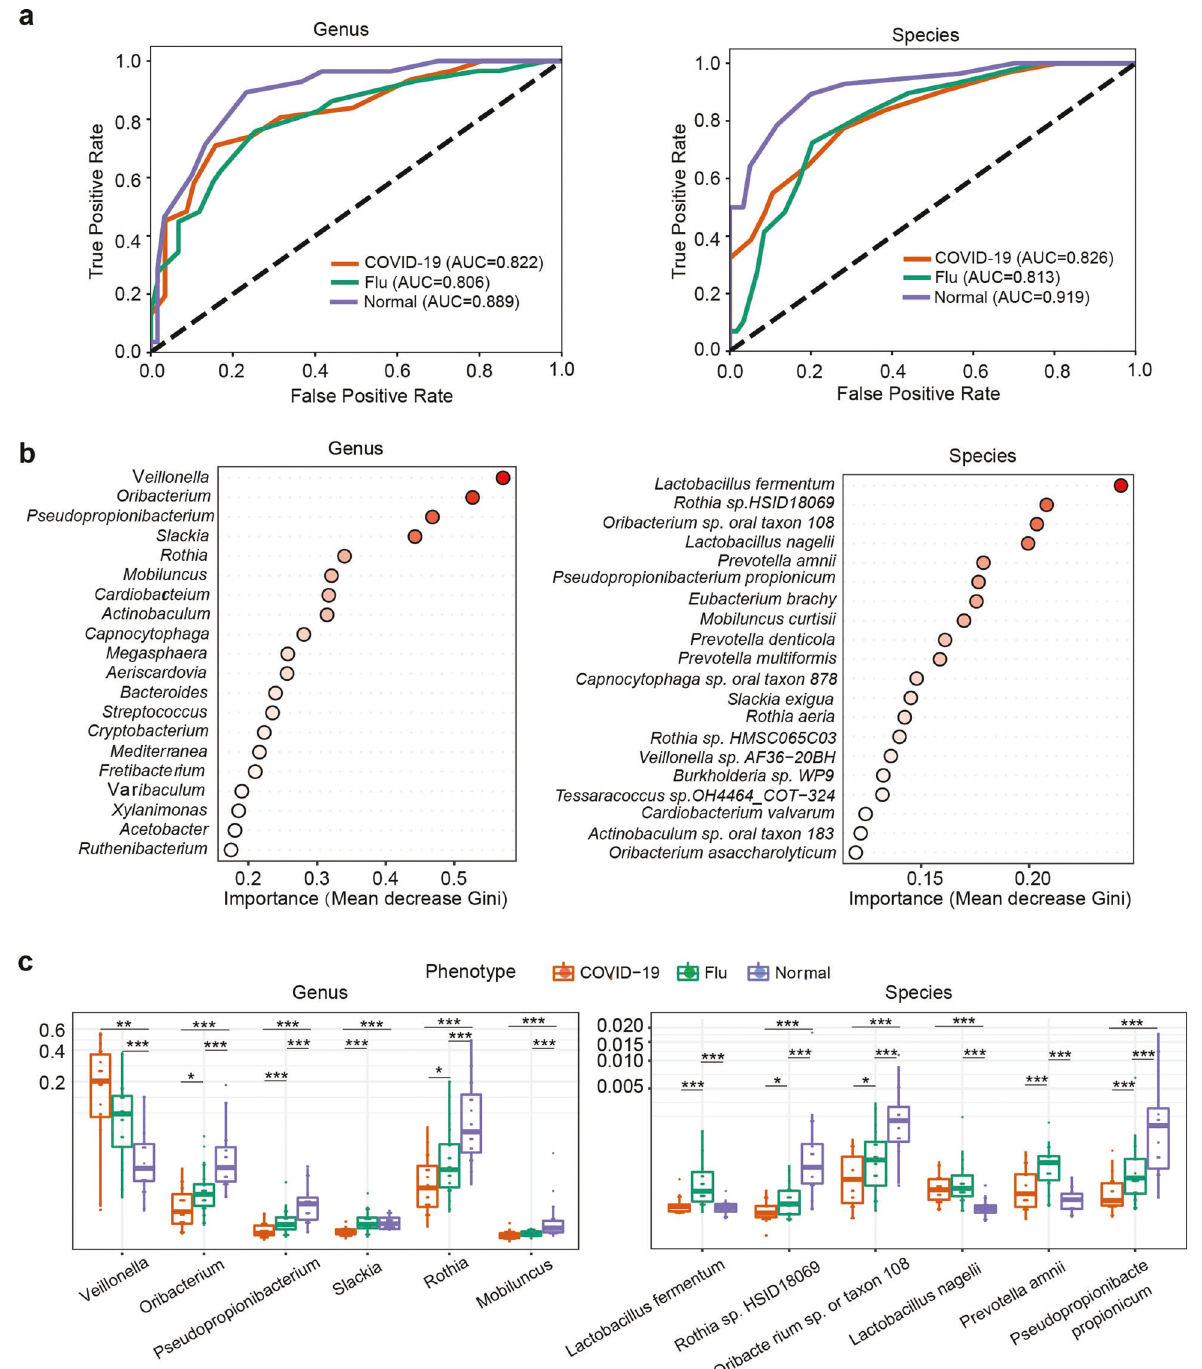
Fig. 4 Main bacterial genera and species classi fi ed in COVID-19 patients, fl u patients, and healthy controls based on random forest analysis. a ROC curves showing the discriminative ability among the three groups (COVID-19, fl u, and normal) using the relative abundance of the oropharyngeal microbiome at the genus and species levels. b Top 20 important genera and species based on Gini importance according to the trained random forest models. c Comparison of the relative abundance of the top 6 genera or species selected based on Gini importance by boxplot. *** P < 0.001; ** P < 0.01; * P < 0.05 using the Kruskal – Wallis (KW) classes of AMR genes are visualized in the heatmap (Fig. 5b). All nitroimidazole, nybomycin, oxazolidinone, penam, penem, pheni- groups included common antibiotics such as lincosamide, col, pleuromutilin, rifamycin, streptogramin, sulfonamide, sulfone, streptogramin, macrolide, and tetracycline. Benzalkonium and tetracycline, and triclosan) were detected, respectively. All 26 AMR nitroimidazole AMR genes occurred only in the COVID-19 group. gene drug classes were detected in the COVID-19 patients. In the fl u patients and healthy controls, only 17 and 24 AMR gene drug The most abundant drug class was penam (274 AMR genes), followed by cephalosporin (261 AMR genes) and penem (256 AMR classes were detected. The relative abundances of these 26 drug